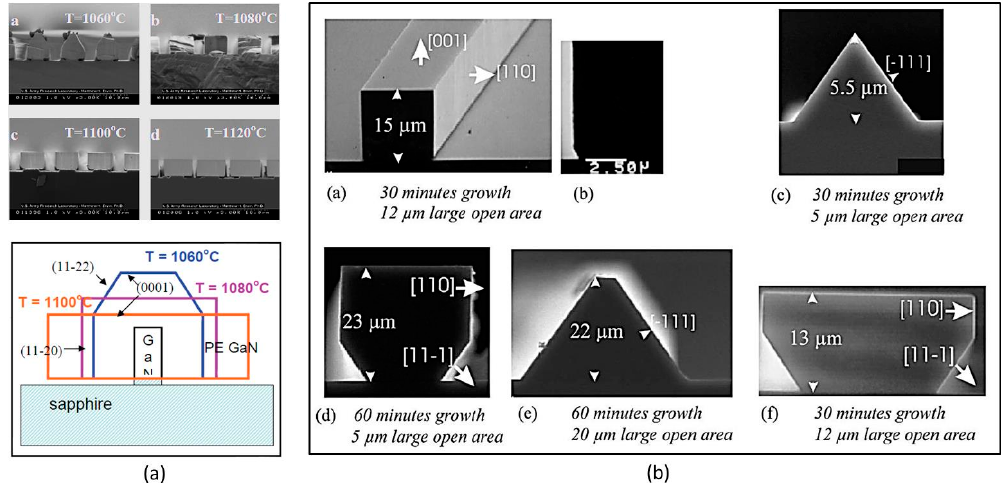
Figure 20. ( a ) Cross sectional images of GaN selective growth performed at different crystallographic